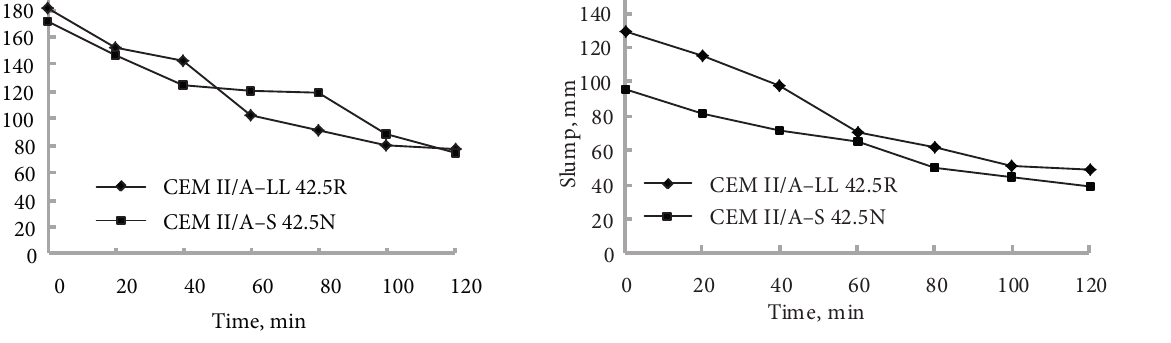
Fig. 1. A concrete mixture with different types of Portland cement and with no dependence of superplasticizer plasticity on time at a temperature of +15